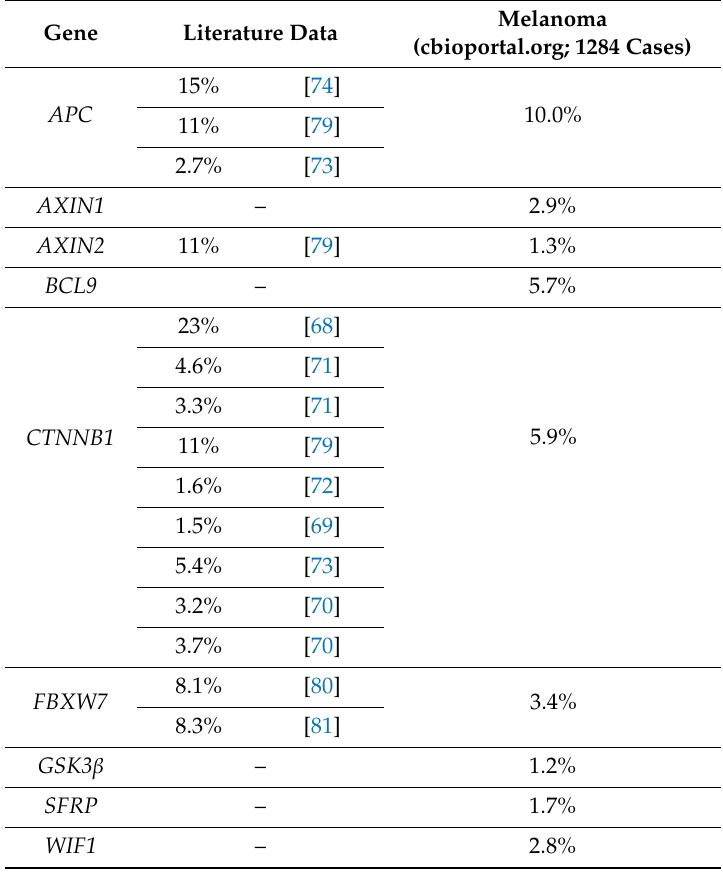
Table 1. Frequency of mutations of genes encoding elements of the canonical WNT-signaling pathway detected in